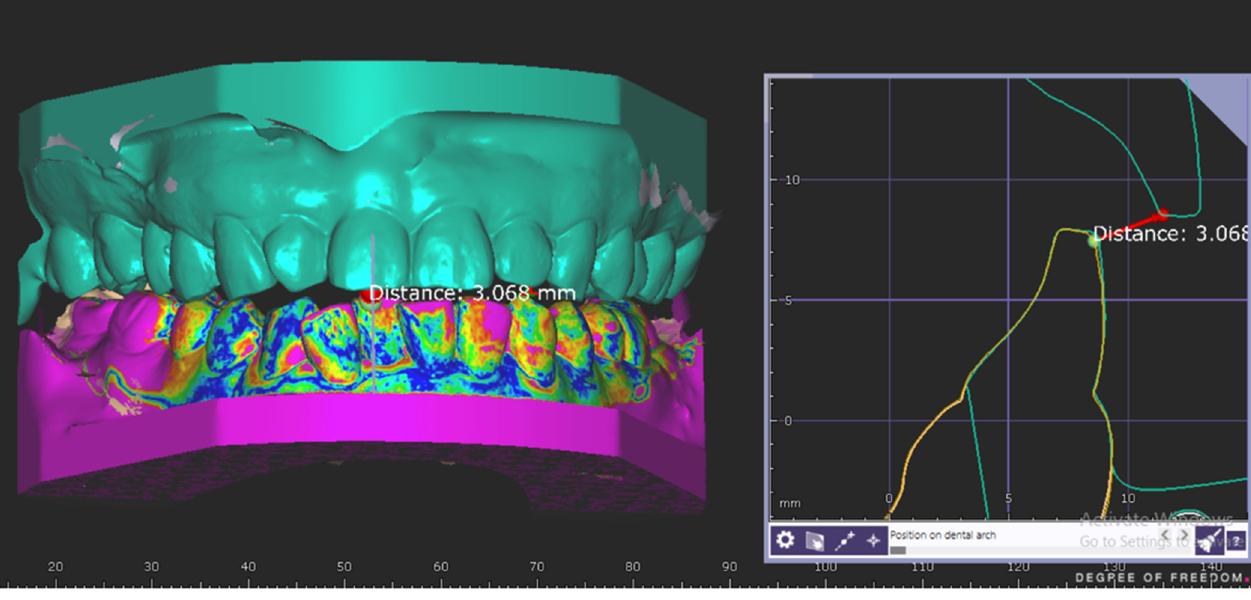
Figure 4. Superimposition and measurement of the anterior opening in the AMG. The mandibular arch scans of OVD + 3 mm (green) and the OVD + 6 mm (yellow) were